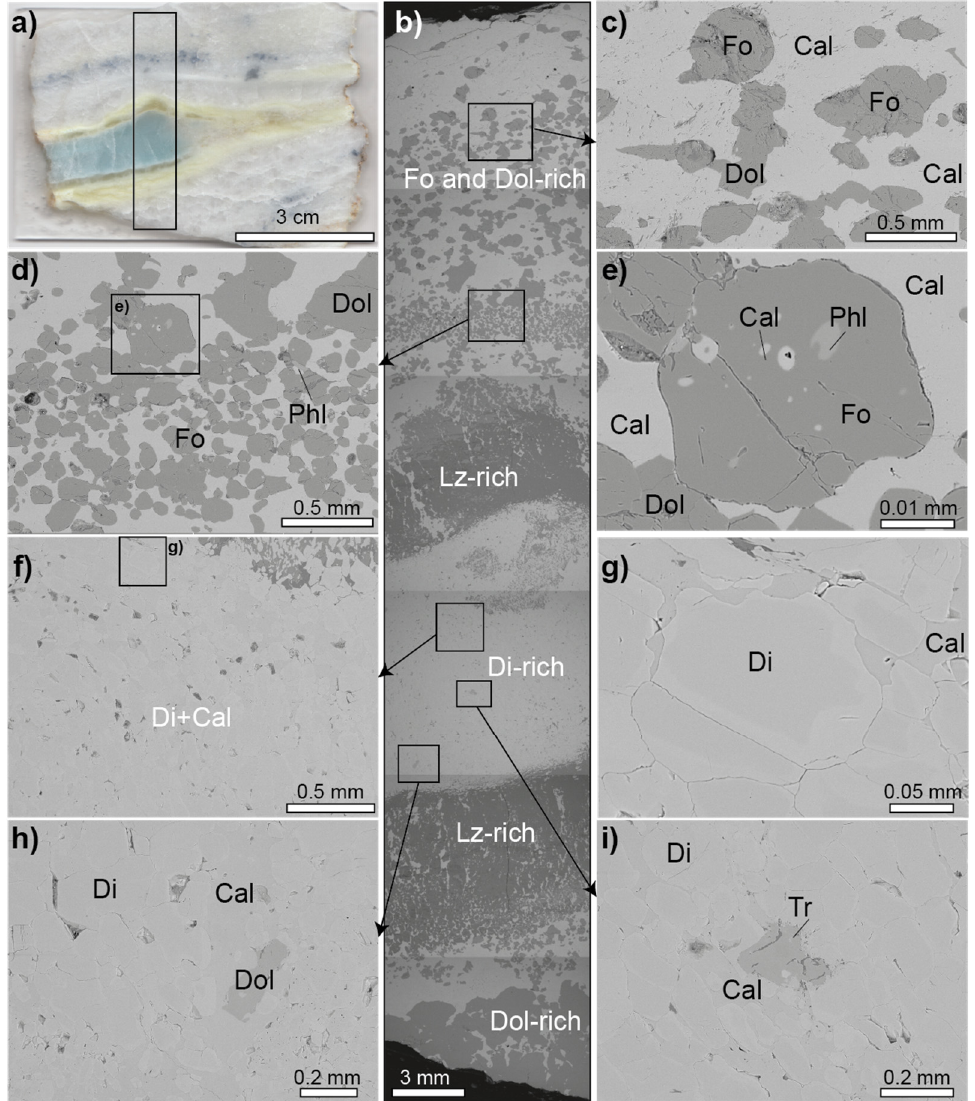
Figure 11. ( a ) Thick section of a sample from the right side of the Sissone valley: the rectangle is the examined portion in ( b ). Images ( c , d , f , h , i ) are magnifications highlighted in ( b ); image ( e ) is the magnification in ( d ) and image ( g ) is the magnification in ( f ). Mineral abbreviations: Di = Diopside; Dol= Dolomite; Fo = Forsterite; Cal = Calcite; Tr = Tremolite; Phl = Phlogopite; Lz = Lizardite [21] (photo by Antonio Langone).